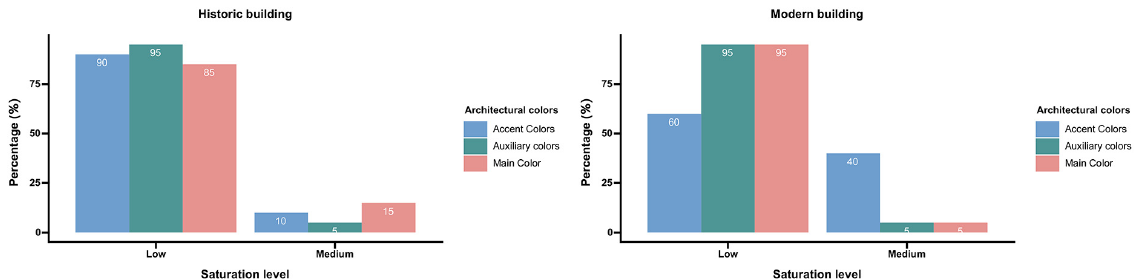
Figure 13. Purity ratio of historic buildings to modern buildings.